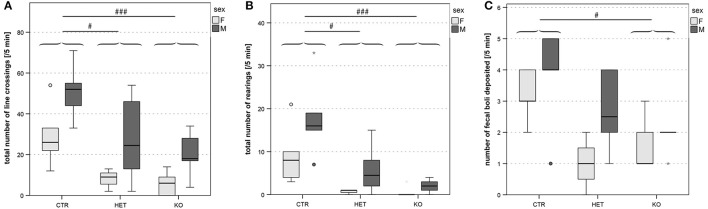
Open field: reduced locomotor- and exploratory activities and grooming. Locomotor activity, estimated from the total number of quadrant line crossings, was higher in males than in females and lower in both KO and HET than in CTR mice (A). Vertical exploration expressed as the total number of rearing was as well lower in both KO and HET than in CTR mice (B). The number of fecal boli deposited was lower in KO than in CTR
(C). Boxes filled in light and dark gray represent data of female and male mice, respectively. (n = 10 CTR, 9 HET, 10 KO). (#p < 0.05, ### p < 0.001).